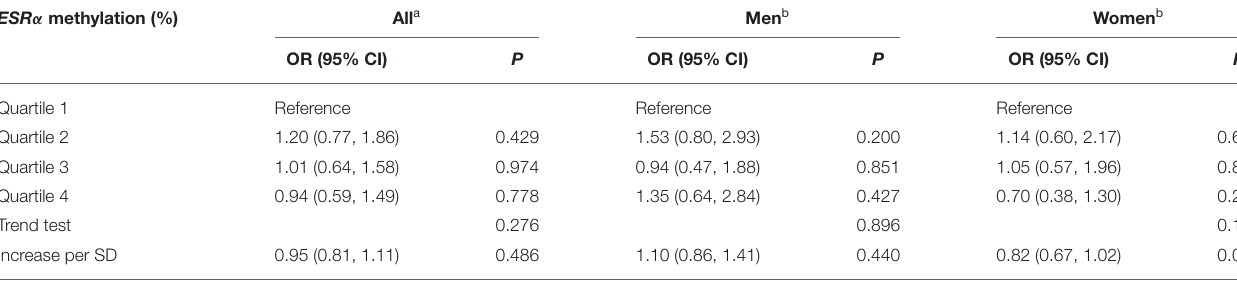
TABLE 4 | Association between ESR α methylation and T2DM.